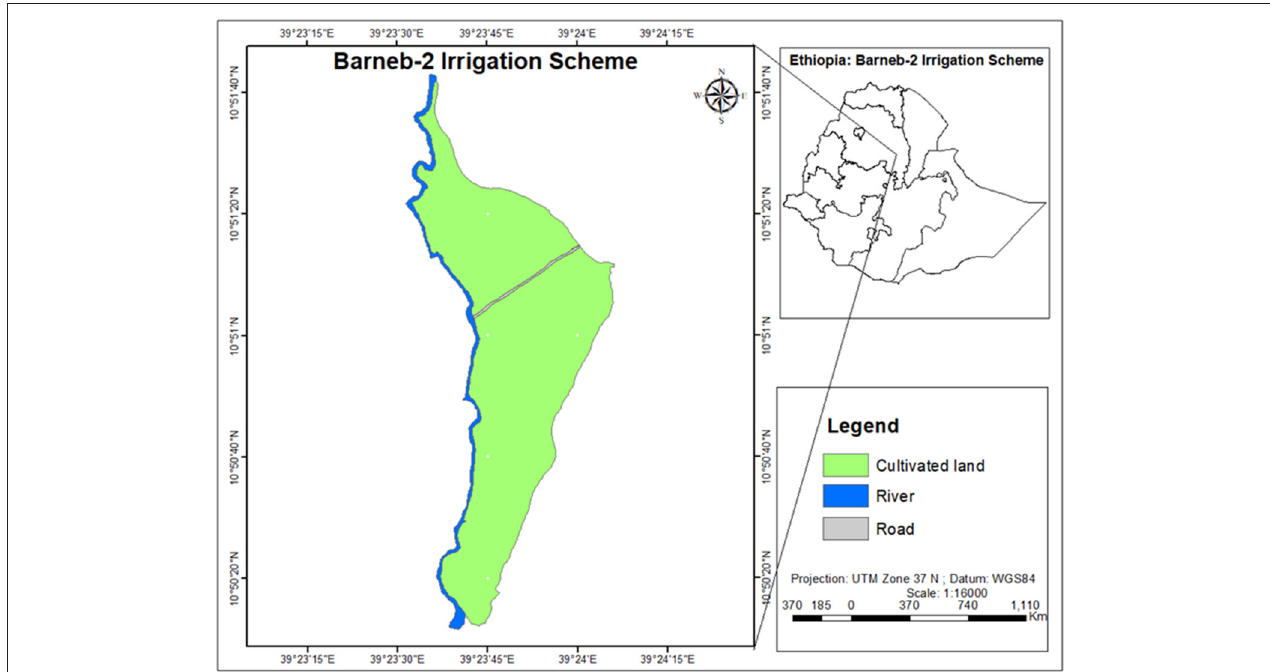
FIGURE 1 | Location of the Barneb 2 community-managed small-scale irrigation scheme in Northeastern Ethiopian highlands.